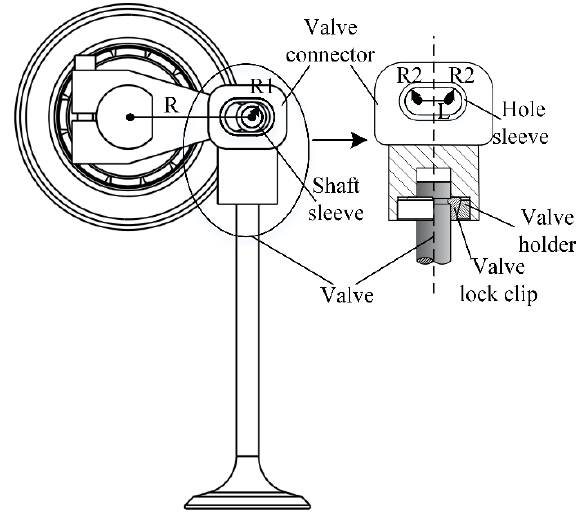
Figure 4. The crank-moving guide rod mechanism.